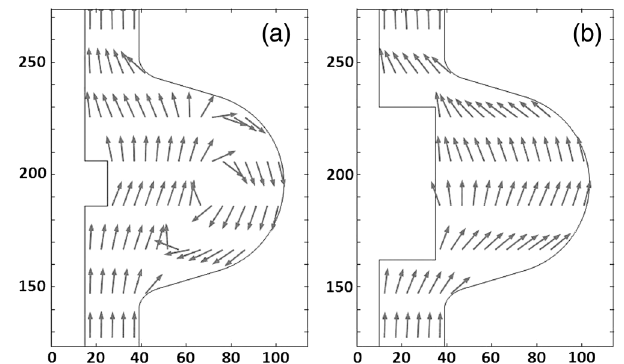
FIG. 7. Direction of the flow modeled with COMSOL for VEP with shape #1 (a) and #2 (b) for low acid flow rate.